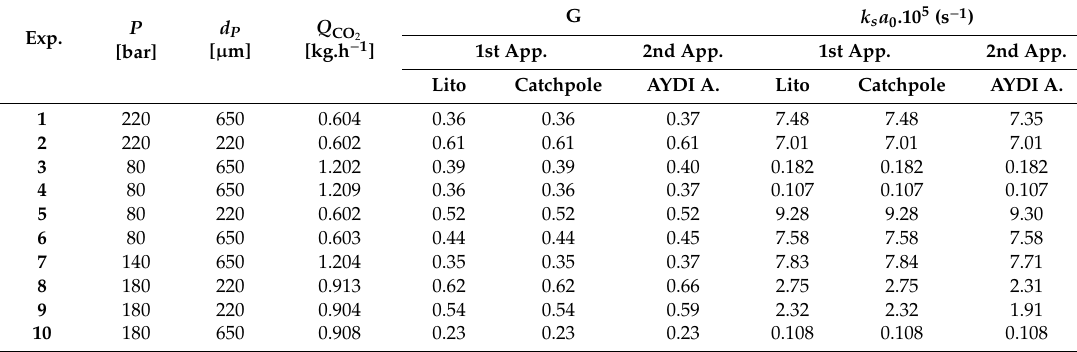
Table 9. The adjusted parameters (G and k s a 0 ) between two approaches.